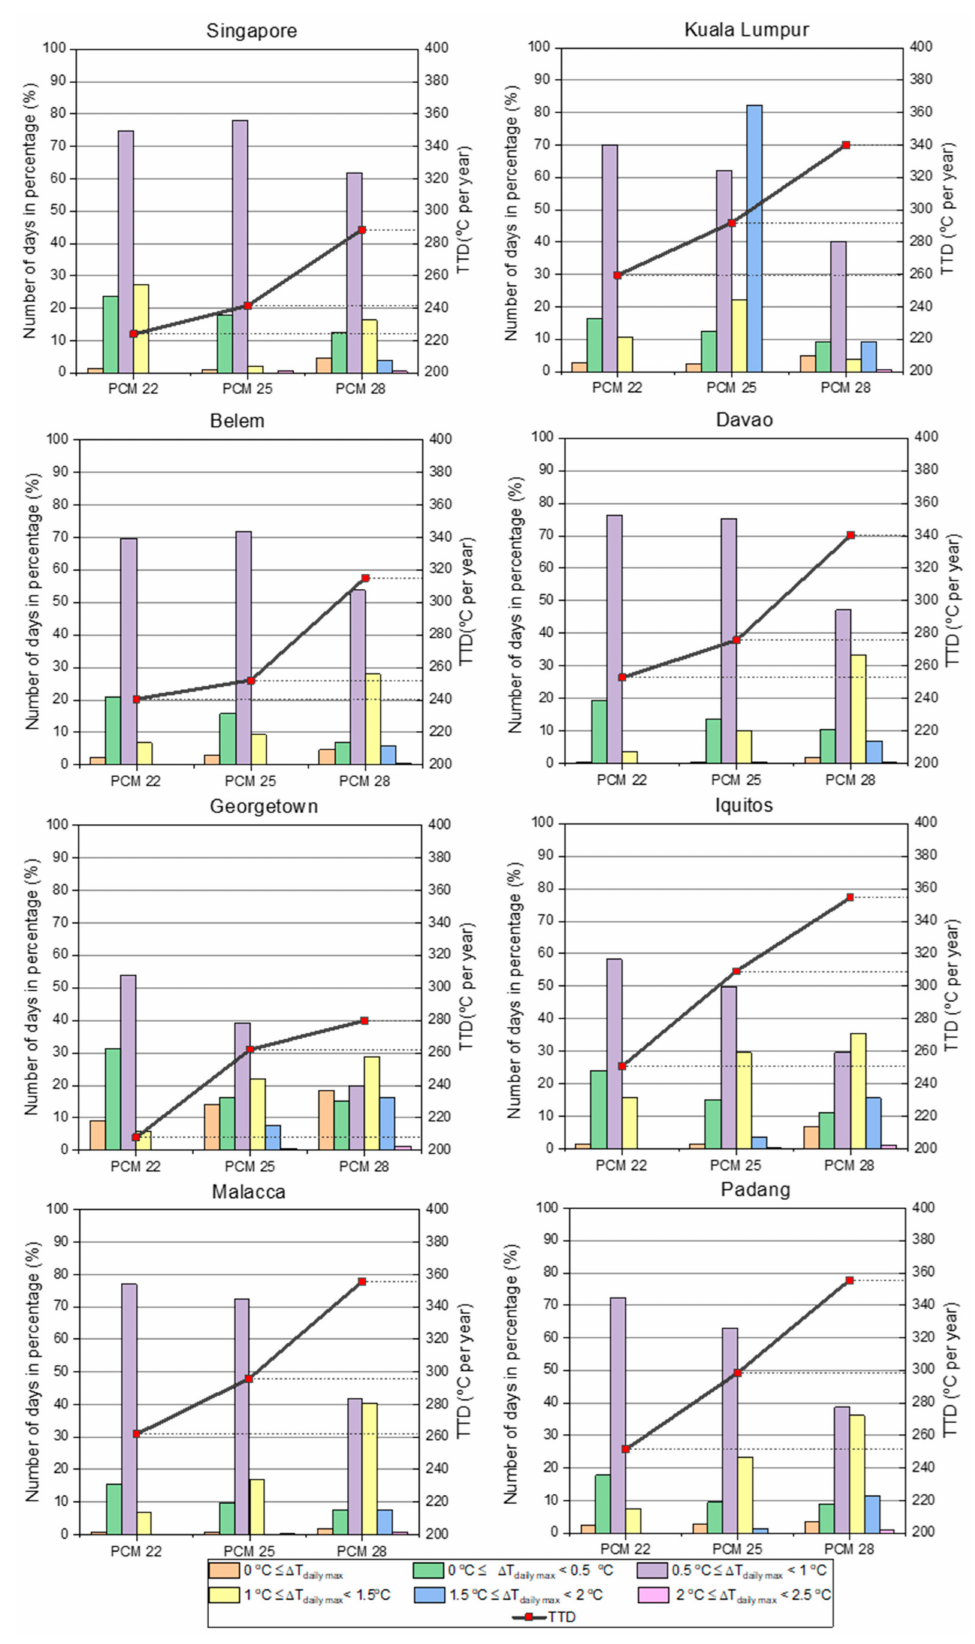
Figure 8. Impact of PCM 22, PCM 25 and PCM 28 on the maximum daily temperature drop and TTD values for all the